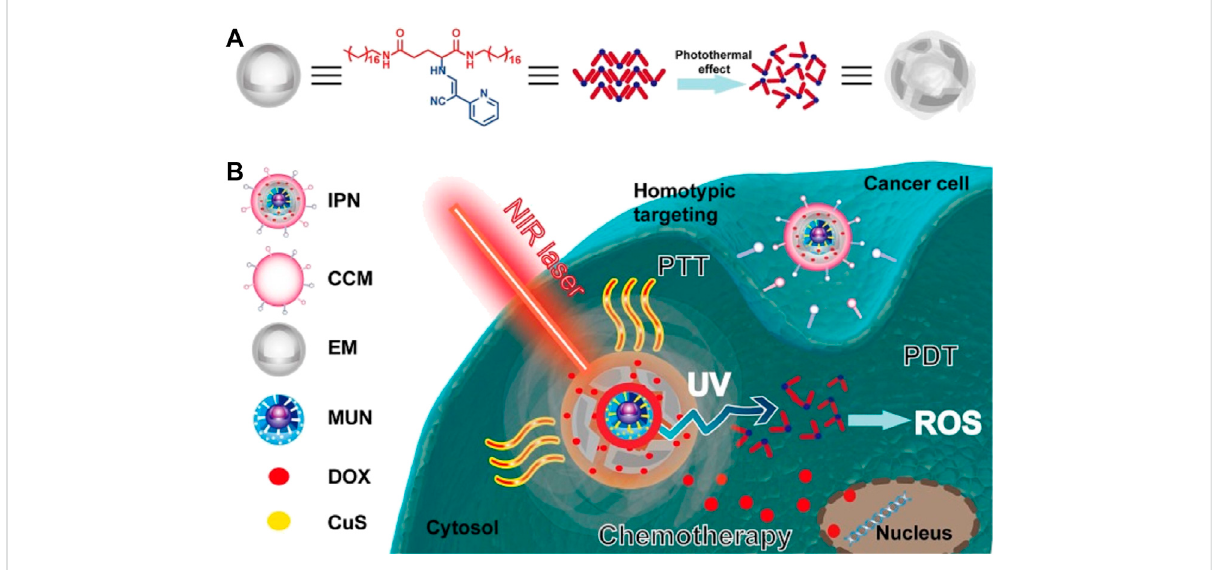
FIGURE 5 Schematic illustration of the intelligent phototriggered nanoparticles. (A) Chemical structure of EM gel and illustration of its photothermally induced phase transition; (B) Main components of IPNs and a schematic illustration of the domino effect induced by IPNs for multimodal tumor therapy. CCM: cancer cell membrane; CuS: copper sul fi de; DOX: doxorubicin; EM: enaminitrile molecular; IPN: intelligent phototriggered nanoparticle; MUN: mesoporous silica-coated UCNP; NIR: near-infrared; PDT: photodynamic therapy; PTT: photothermal therapy; ROS: reactive oxygen species; UV: ultraviolet (UV); UCNP: upconversion nanoparticle. Reproduced with permission from reference (Xu et al., 2021). Copyright © The